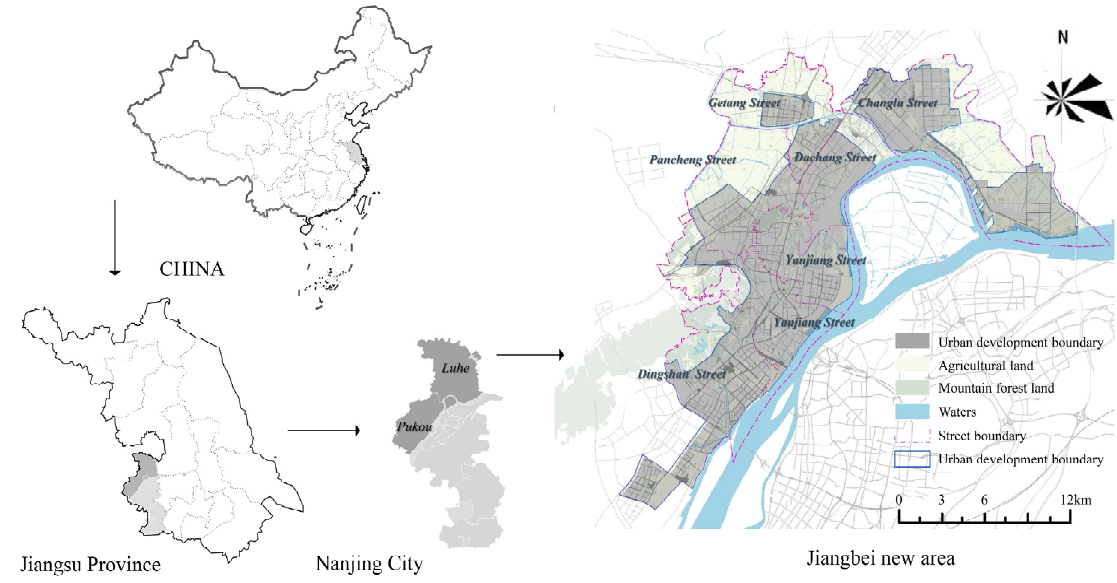
Figure 1. The study area.